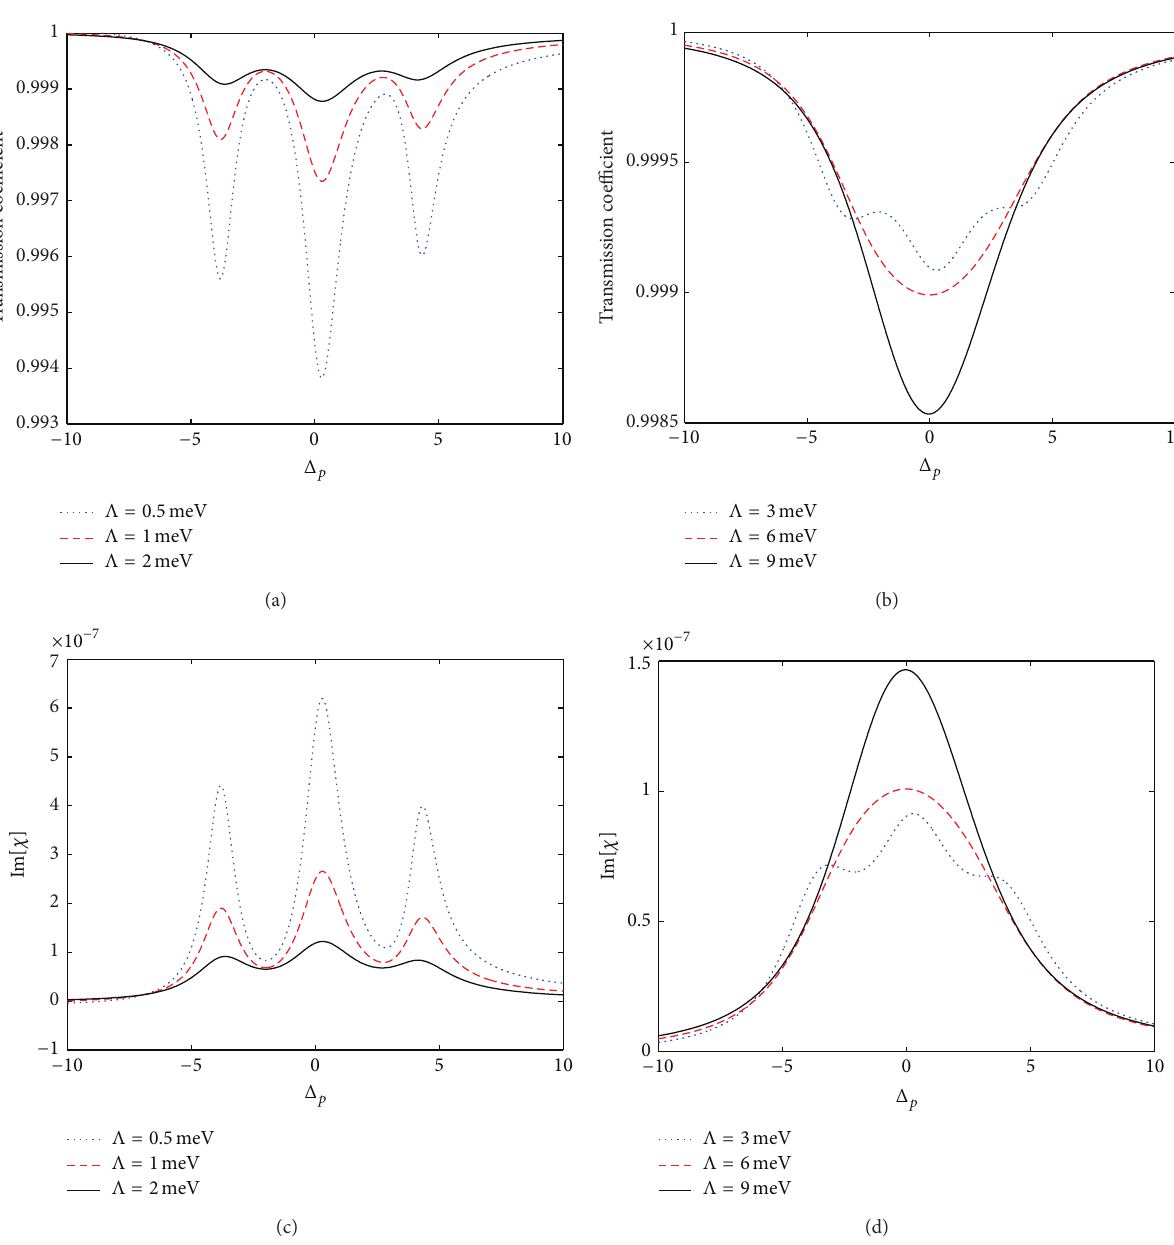
Figure 5: Transmission coefficient ((a), (b)) and probe absorption ((c), (d)) versus probe field detuning. for different values of incoherent pumping. The selected parameters are 𝑇 1 = 𝑇 2 = 2 meV and the other parameters are the same as in Figure